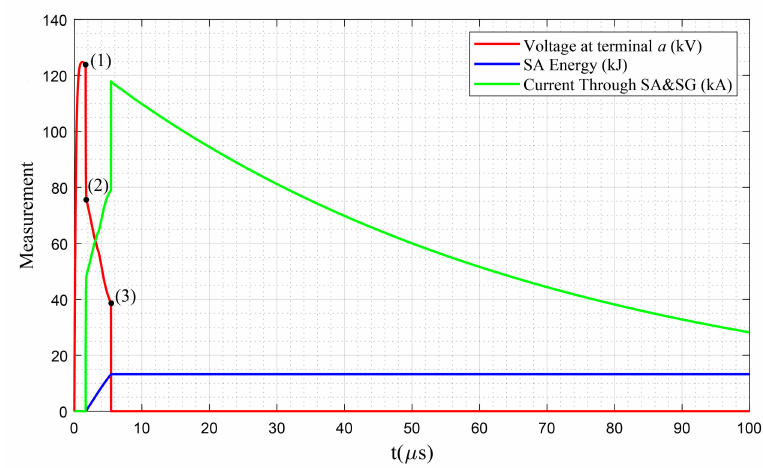
Figure 19. Performance of surge arrester and spark gap connected in series; scenario 2, SA-12a under 125 kV lightning